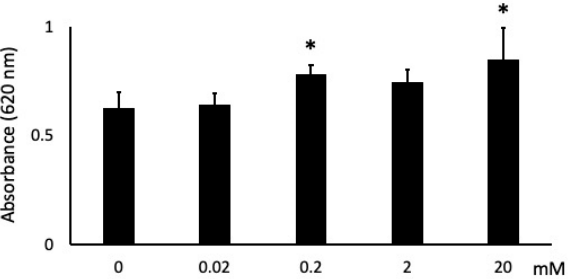
Figure 3. Effects of butyric acid (BA) on cell attachment. Cells were incubated with several concen- trations of sodium butyrate (NaB), 0 mM, 0.02 mM, 0.2 mM, 2 mM and 20 mM, for 1 h. * Significantly different from control cells (0 mM) ( p < 0.05). Values are the mean ± standard deviation from eight independent experiments.